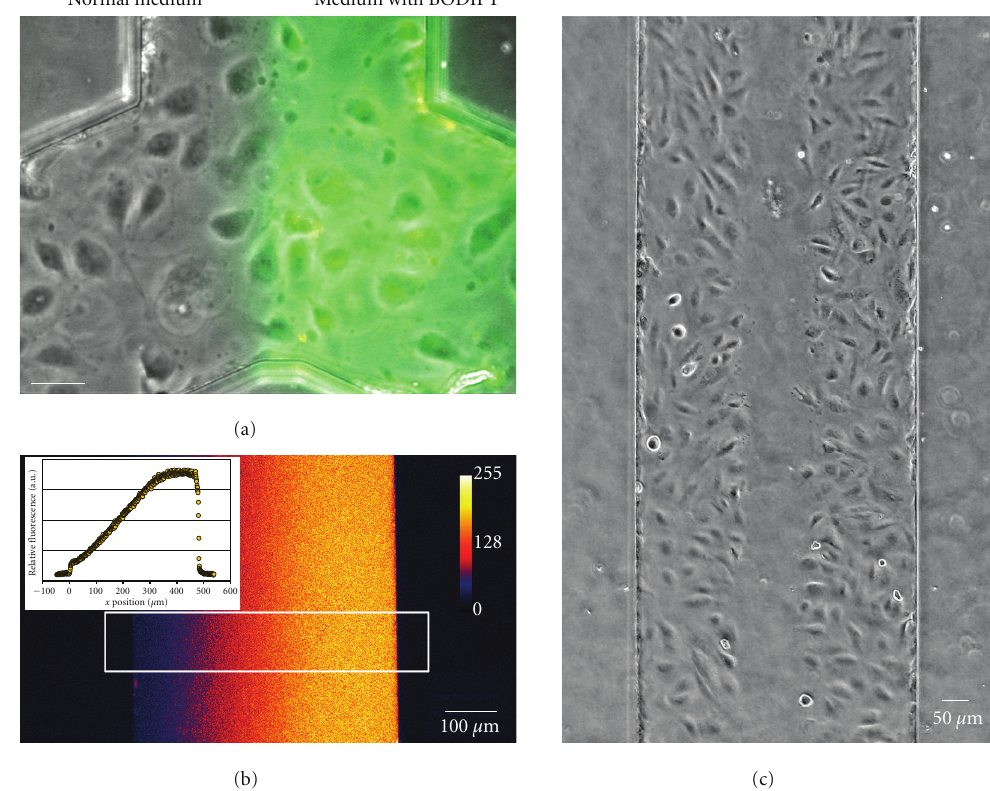
Figure 5: Uses of parallel fluid flows inside microfluidic channels. (a) Parts of the microfluidic channel can be treated di ff erently by pumping two types of media into the two inlets. In this case, a fluorescent label was added to one of the parallel fluid streams. Flow is from bottom to top; scale bar is 50 μ m. (b) When flow rates are su ffi ciently low, media reside in the channel long enough for di ff usion to take place. This phenomenon can be used to generate and maintain steady gradients in a channel. In this case, three parallel inlet streams were used, containing 0 μ g/mL, 5 μ g/mL, and 10 μ g/mL dextran-rhodamine, respectively. When quantifying the fluorescence over the width of the channel, an almost linear gradient can be observed (white square box in the image, plotted in the inset). (c) By using parallel flows, the middle part of the channel was treated with trypsin. As a result, endothelial cells in the middle of the channel are selectively removed, creating an artificial wound. The closing of this wound can be followed over time to quantify cell migration